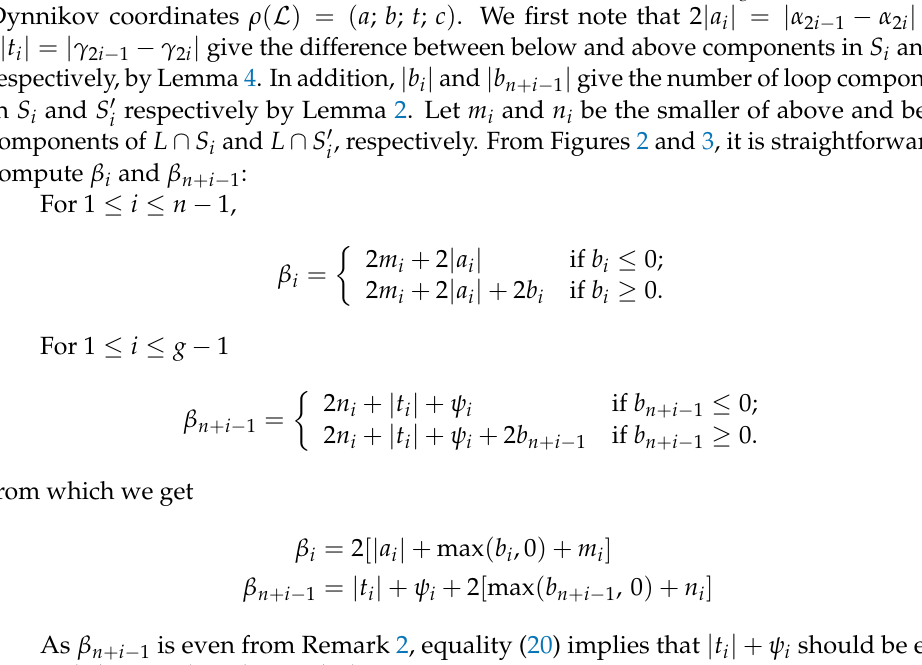
in N 3,1 with generalized Dynnikov coordinates ρ ( L